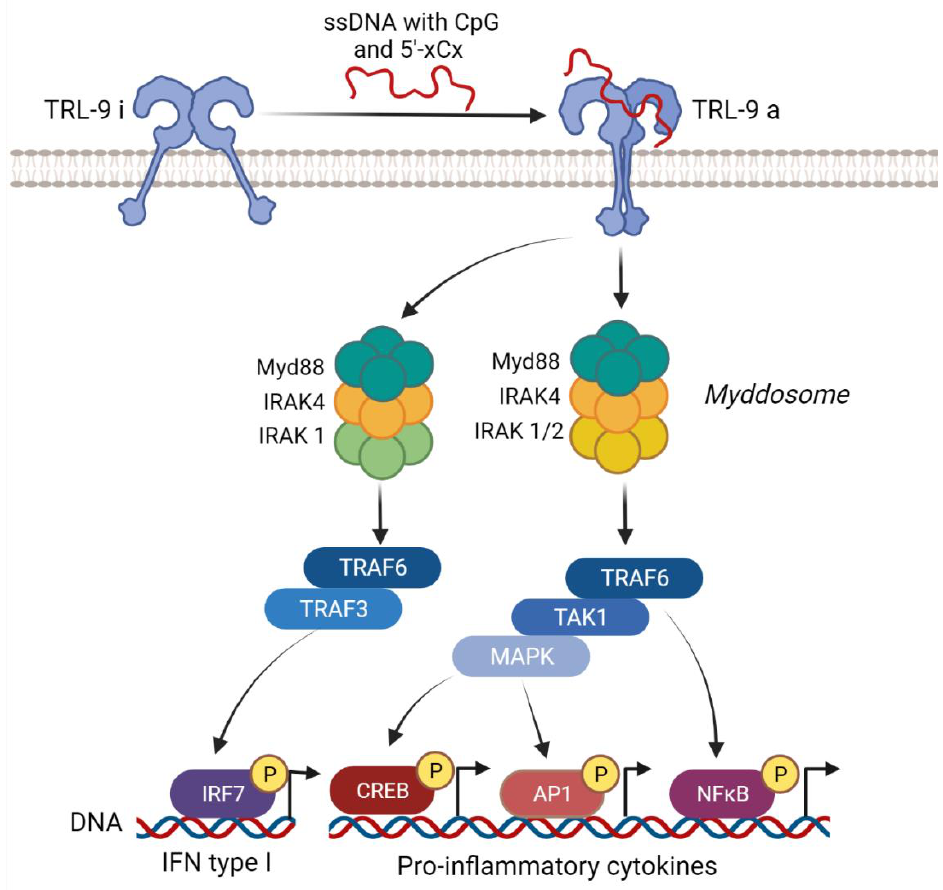
Figure 2. TRL9 pathway activation in response to DNA. TLR9 recognizes ssDNA enriched with CpG and 5 ′ -xCx DNA motifs and changes the conformation of the TLR9 dimers. Dimers come into closer proximity and bind to the Myd88 adaptor. The adaptor recruits IRAK kinases and forms (i) myddosomes composed of MyD88, IRAK4, IRAK1, and IRAK2 that promote the sequential recruitment of TRAF6, TAK1, and MAPKs, leading to the activation of the transcription factors NF- κ B, AP-1, and CREB for the production of inflammatory cytokines or alternatively (ii) myddosomes composed of MyD88, IRAK4, and IRAK1 promote the sequential recruitment of TRAF6 and TRAF3, leading to the activation of IRF7 and the production of IFN. Created with